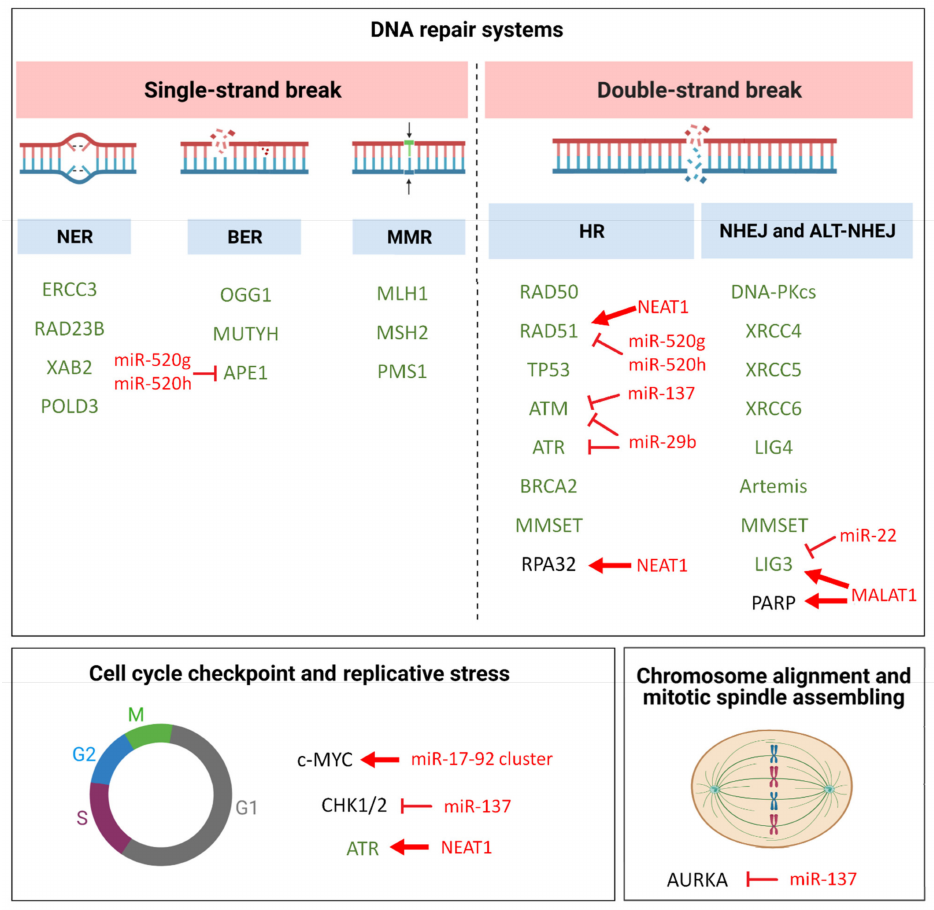
Figure 1. Schematic diagram illustrating pathways involved in GI molecular mechanisms in MM. Genes with known aberrant expression or function in MM are reported in green and discussed in the main text; miRNA and lncRNAs targeting crucial players of these pathways in MM are reported in red, along with their putative/predicted molecular effect. Red bar-headed arrows indicate inhibiting effects, while red arrows indicate activating